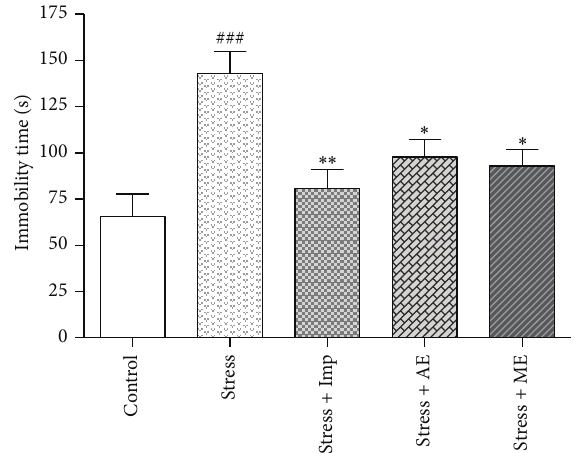
Figure 9: Effect of aqueous and methanolic seed extracts of Abelmoschus esculentus on the duration of immobility in the forced swimming test in mice. The Imp, AE, and ME groups were daily treated with imipramine (12mg/kg, i.p.), aqueous, and methanolic seed extracts (200 mg/kg, p.o.), respectively, for 7 days once daily and then stress was induced after 30 min of last dose. The values shown are the mean ± S.E.M (𝑛 = 6) ; ### 𝑃 < 0.001 when compared to control group, ∗ 𝑃 < 0.05 and ∗∗ 𝑃 < 0.01 when compared to stressed